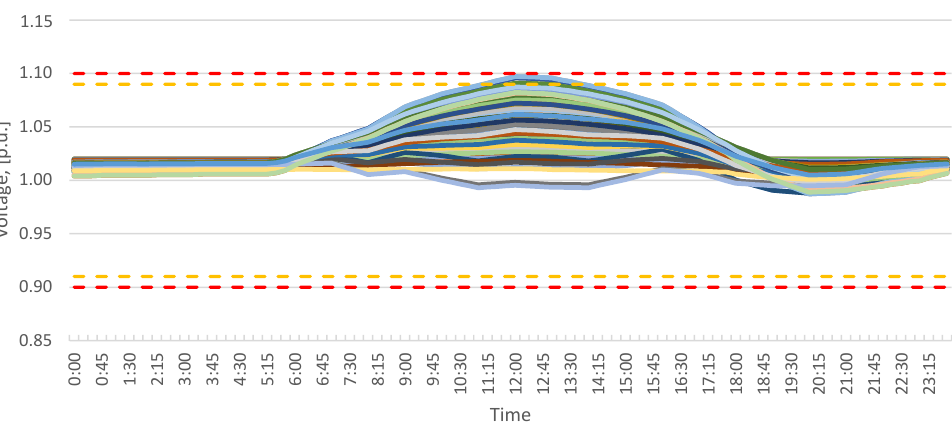
Figure 11. Inductive network voltage profiles, before the application of the